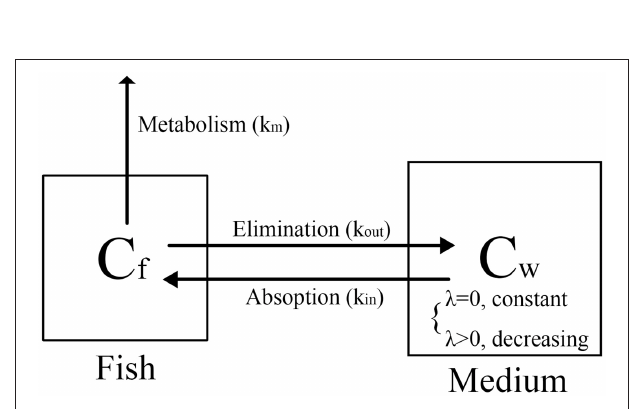
FIGURE 4 | Proposed distribution process in zebrafish